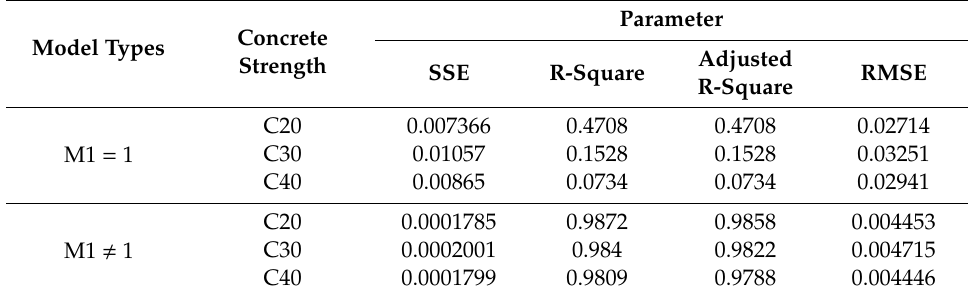
Table 8. Fitting goodness of the dynamic elastic modulus degradation model. Legend: SSE, sum of squares due to error; RMSE: root mean square error; R-Square: coe ffi cient of